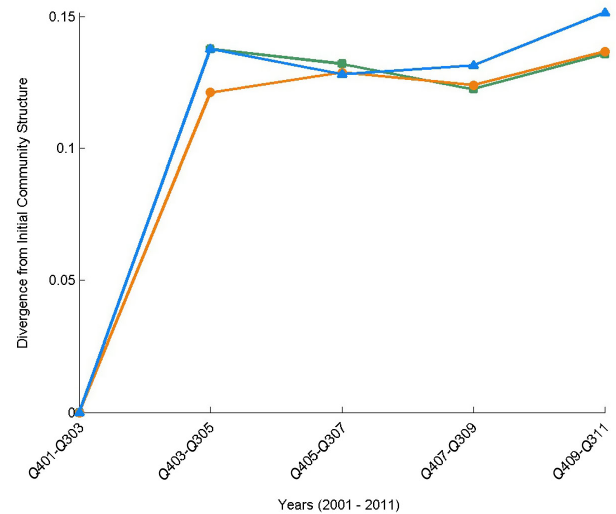
FIG. 17. Temporal trend of VI showing the similarity in community structure for the different algorithms over a two-year sliding window spanning the time frame from October 2001 to October 2011. (The Potts algorithm is shown by green squares, the Louvain algorithm by orange circles, and the spectral algorithm by blue